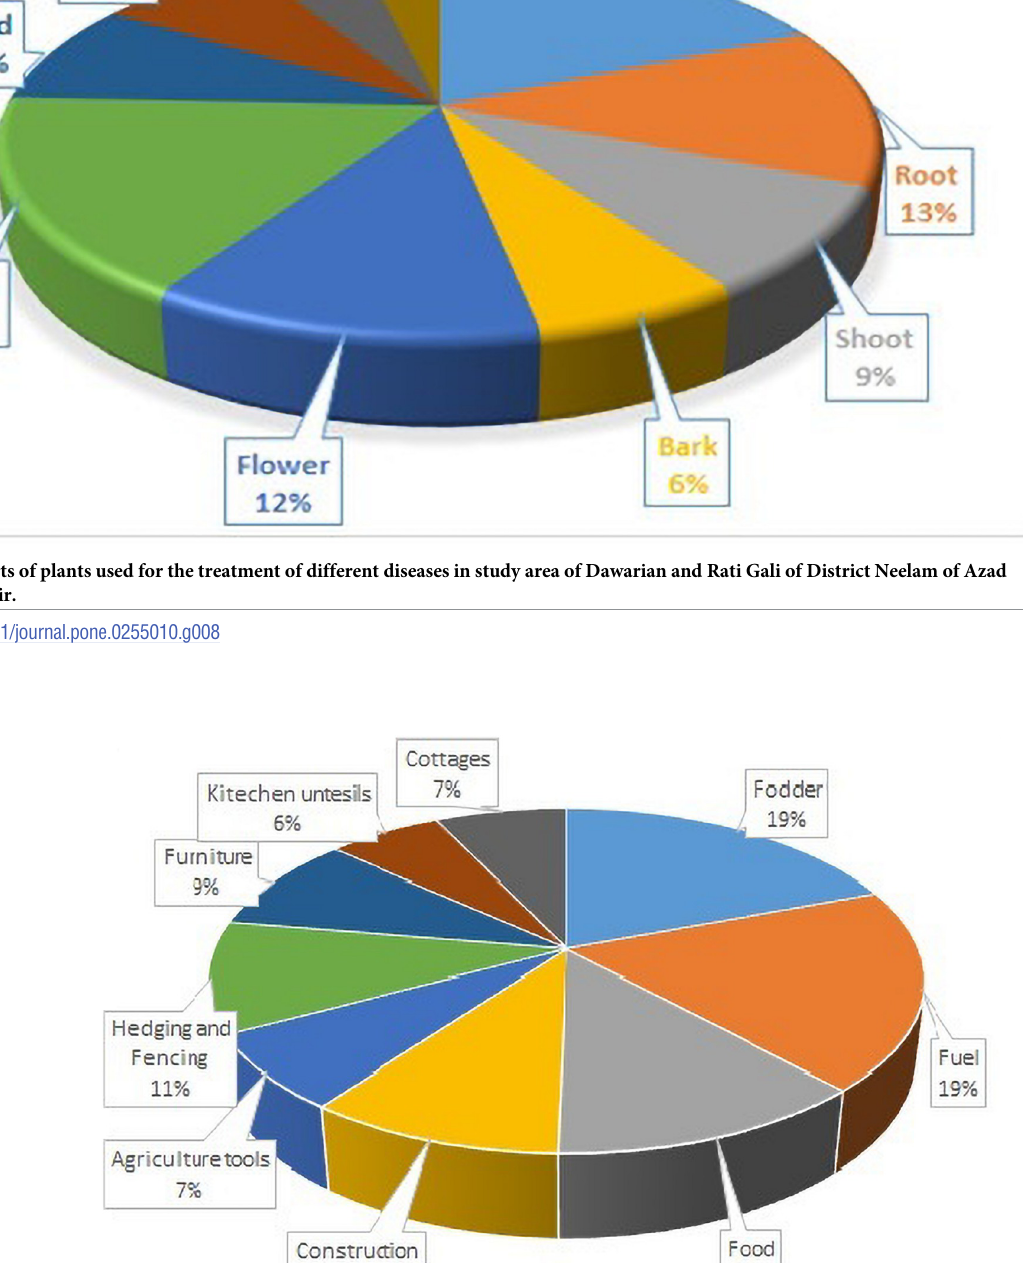
PLOS ONE | https://doi.org/10.1371/journal.pone.0255010 July 29, 2021 21 /